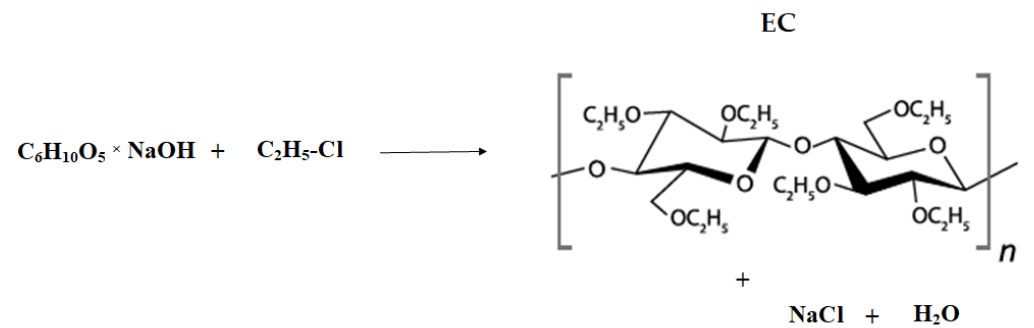
Figure 1. Schematic illustration of ethylcellulose (EC)